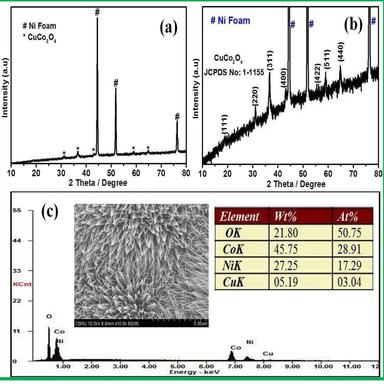
XRD pattern of (a) CuCo2O4 nanowires, (b) Enlarge in Fig (a), (c) EDX spectrum of CuCo2O4 nanowires (Inset: FESEM images of CuCo2O4 nanowires).